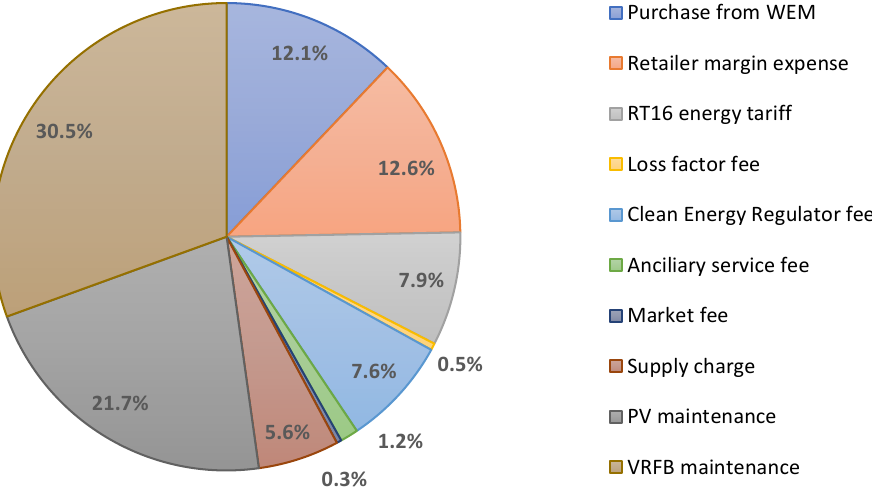
Figure 11. The breakdown of NPV revenue (AUD) over 20 years for the VPP in Case I.